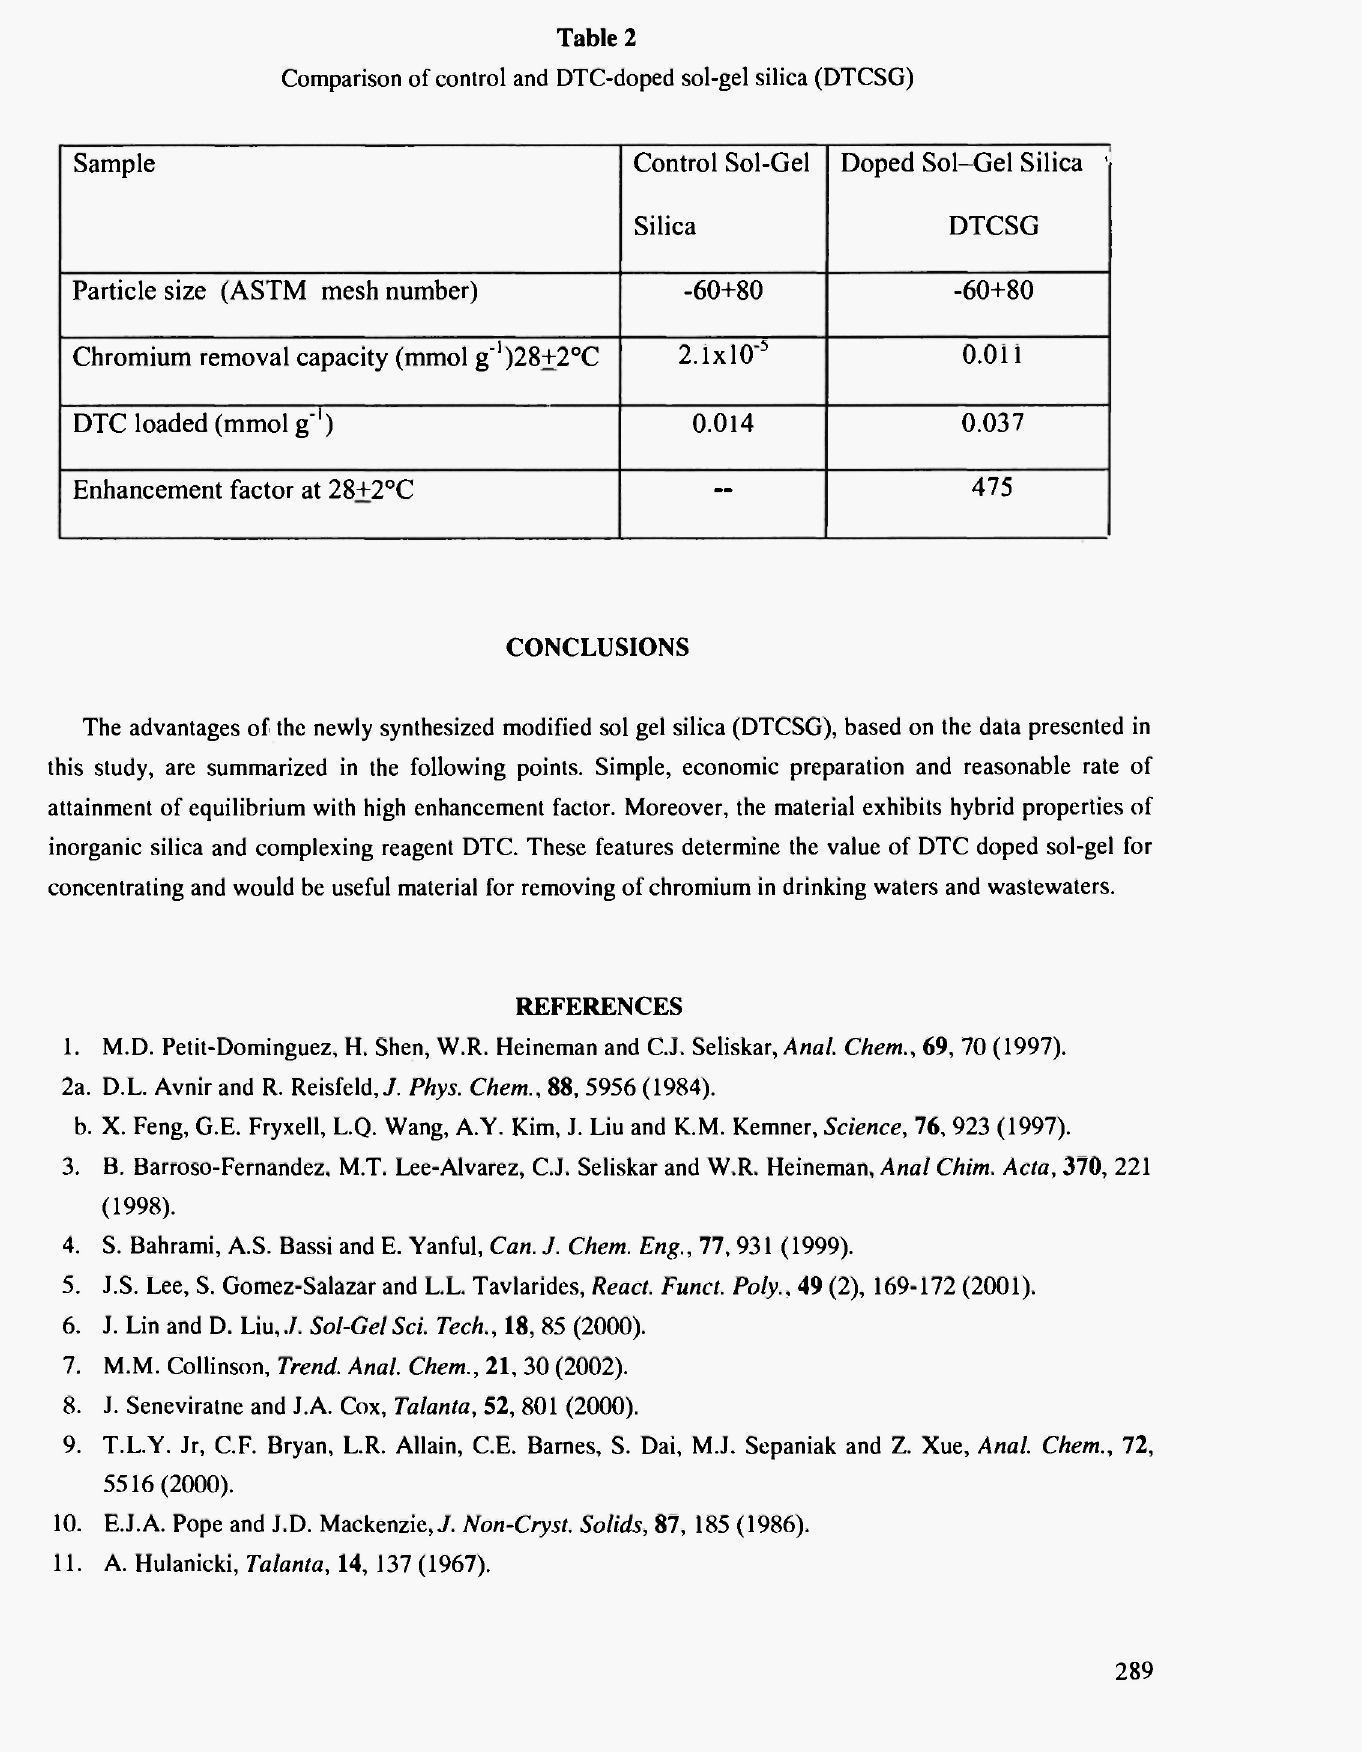
Comparison of control and DTC-doped sol-gel silica